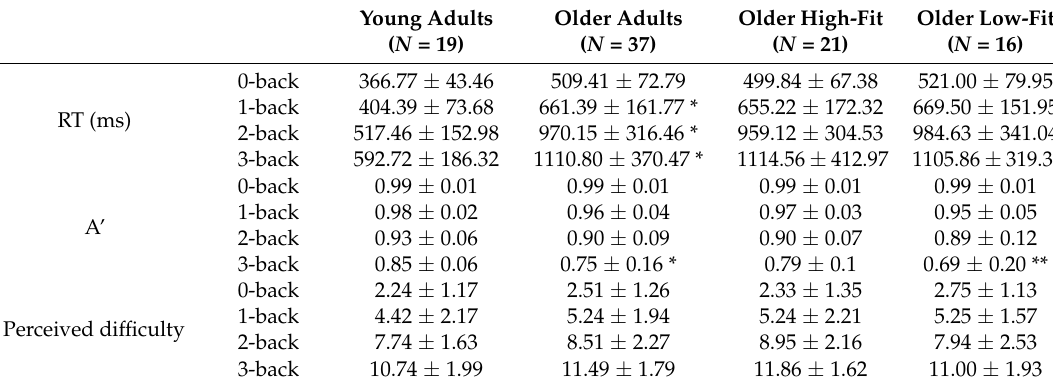
Table 2. Evolution of behavioral data as a function of cognitive load and